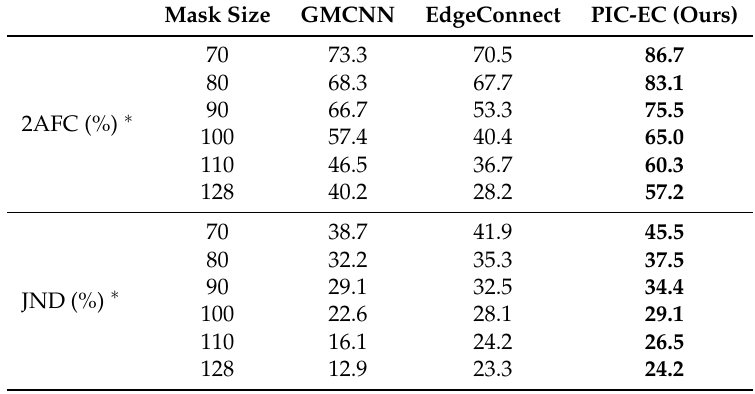
Table 7. User study results over the Paris StreetView for six different squared masks with methods: GMCNN, EdgeConnect and PIC-EC. Boldface in each row indicates the best performance. ∗ Higher is